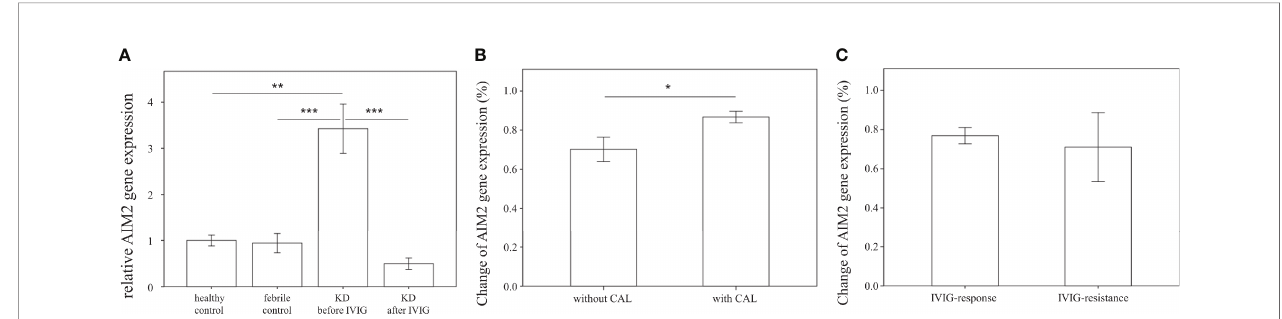
FIGURE 4 | Comparison of relative AIM2 mRNA expression. (A) Relative AIM2 mRNA expression levels in healthy controls (n=23, mean ± SEM 1 ± 0.11), febrile controls (n=24, mean ± SEM 0.94 ± 0.21), and in Kawasaki disease patients before IVIG (n=71, mean ± SEM 3.43 ± 0.53) and after IVIG (n=71, mean ± SEM 0.50 ± 0.12). (B) Comparison of relative AIM2 percent changes before and after IVIG therapy in KD patients without CAL (n=46, mean ± SEM 0.70 ± 0.06) and with CAL (n=25, mean ± SEM 0.87 ± 0.03). Percentage changes were calculated using the following equation (KD1-KD2)/KD1 * 100%. (C) Comparison of relative CD36 percent changes before and after IVIG therapy in KD patients with adequate IVIG response (n=62, mean ± SEM 0.77 ± 0.04) and with IVIG resistance (n=9, mean ± SEM 0.71 ± 0.18). Percentage changes were calculated using the following equation (KD1-KD2)/KD1 * 100%. An asterisk denotes a p-value of less than 0.05.